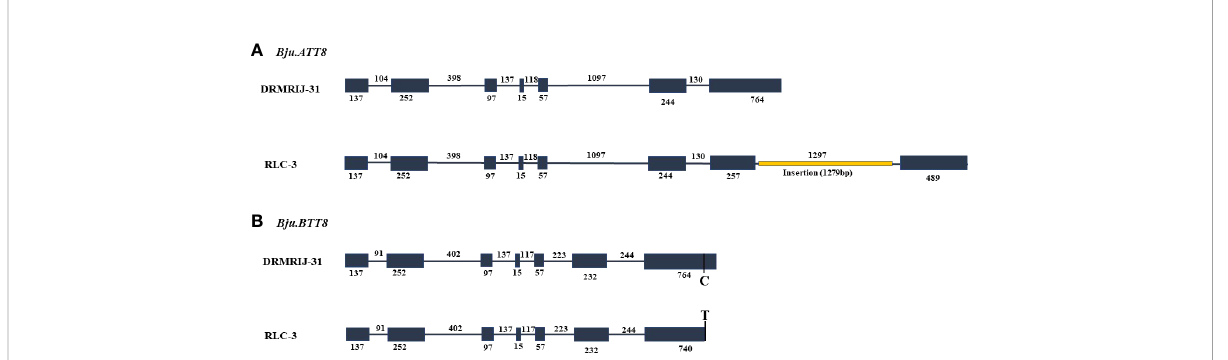
FIGURE 2 Gene structure of Bju.TT8 homologs, exonic region represented by grey boxes and grey line denoting the intronic region (A) Diagrammatic representation of Gene differences observed in DRMRIJ-31 and RLC-3 for Bju.ATT8 gene, RLC-3 had large insertion of 1279 bp (depicted by orange line) in the seventh exon (B) Gene differences observed in DRMIJ-31 and RLC-3 for Bju.BTT8 gene, RLC-3 had a SNP (C ! T) in the seventh